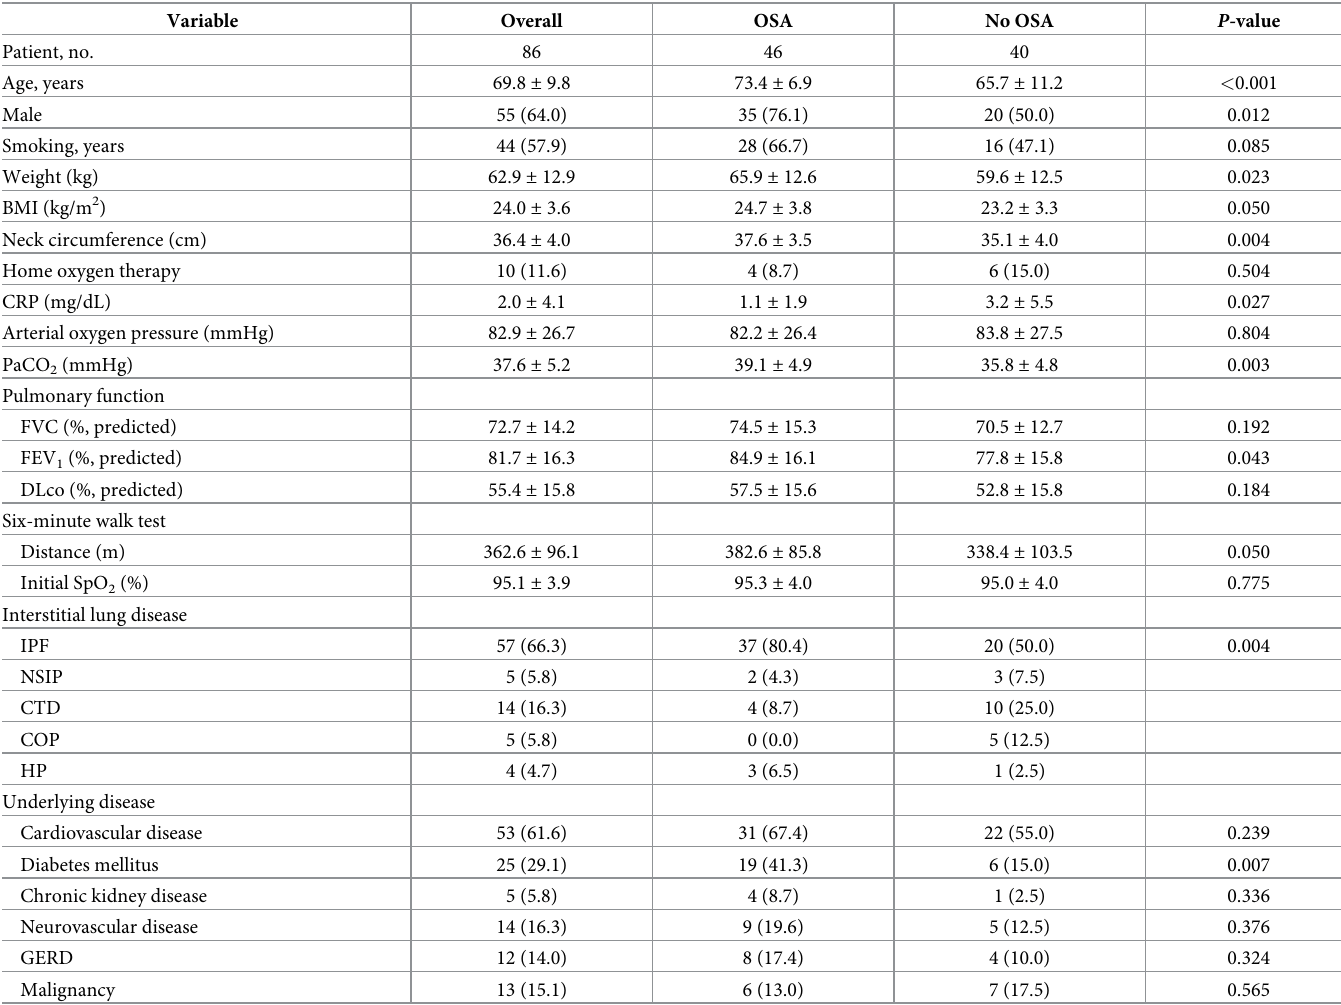
Table 1. Comparison of baseline characteristics between OSA and no OSA groups. Variable Overall